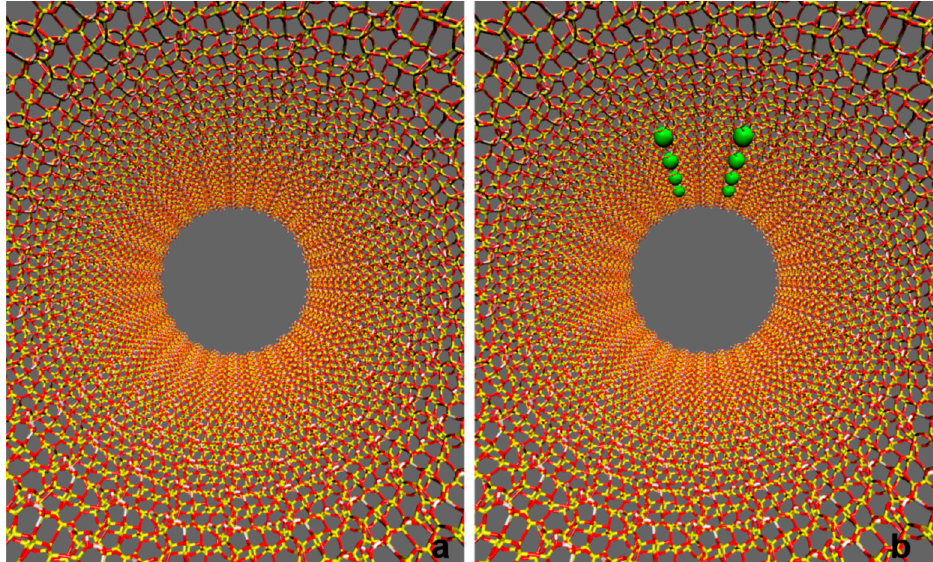
Figure 10. Graphical representations of the adopted silica mesopore model. Atom color codes: Si: yellow; O: red; H: white. Panel ( a ) Model 1: hydroxylated neutral surface. Panel ( b ) Model 2: surface with − 8 | e | charge. The green spheres on the charged surface mark the positions of the deprotonated silanol oxygens.